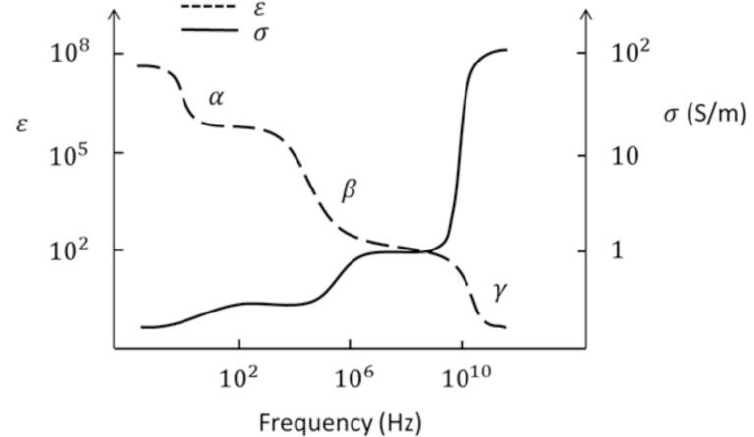
Figure 11. The dispersions of biological samples. The above-mentioned increase in conductivity is called dispersion. In biological systems, there are mainly three kinds of dispersions ( α , β , γ ). According to the phenomenon of dispersion, it is divided into three frequency bands. The frequency range of α dispersion is from millihertz to hundreds of hertz, and it is mainly related to the phenomenon of tissue polarization. The frequency range of β dispersion caused by the Maxwell-Wagner effect is from hundreds of hertz to megahertz. It is a method of measuring the integrity of cell membranes during meat aging because of reduced insulation properties. The frequency range of the γ -dispersion is in gigahertz, which is mainly caused by the permanent dipole relaxation of free water in muscle tissue. This characteristic also further proves the reliability of the electrical method for detecting meat products. In fact, electrical detection can be divided into contact measurement methods and non-contact measurement methods. The response speed of the electrode contact measurement method is fast and accurate. However, the contact method may cause unnecessary measurement errors, such as